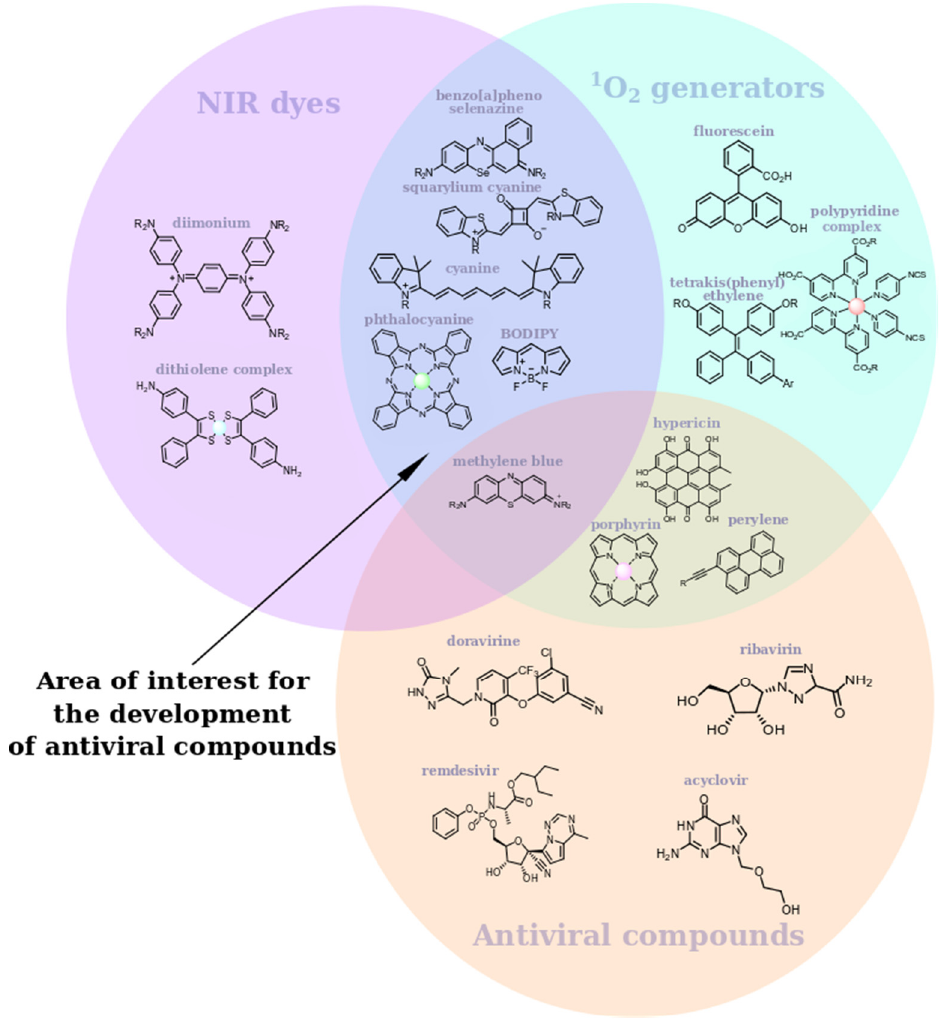
Figure 5. Analysis of prospective antiviral photosensitizing scaffolds.